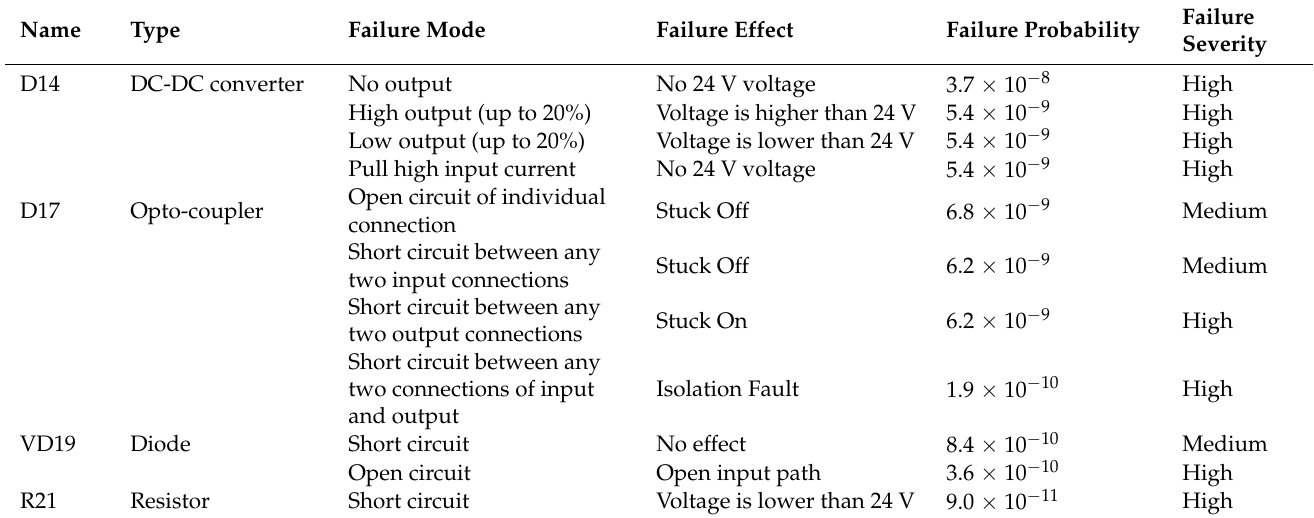
Table 6. FMECA example prepared by expert 1.